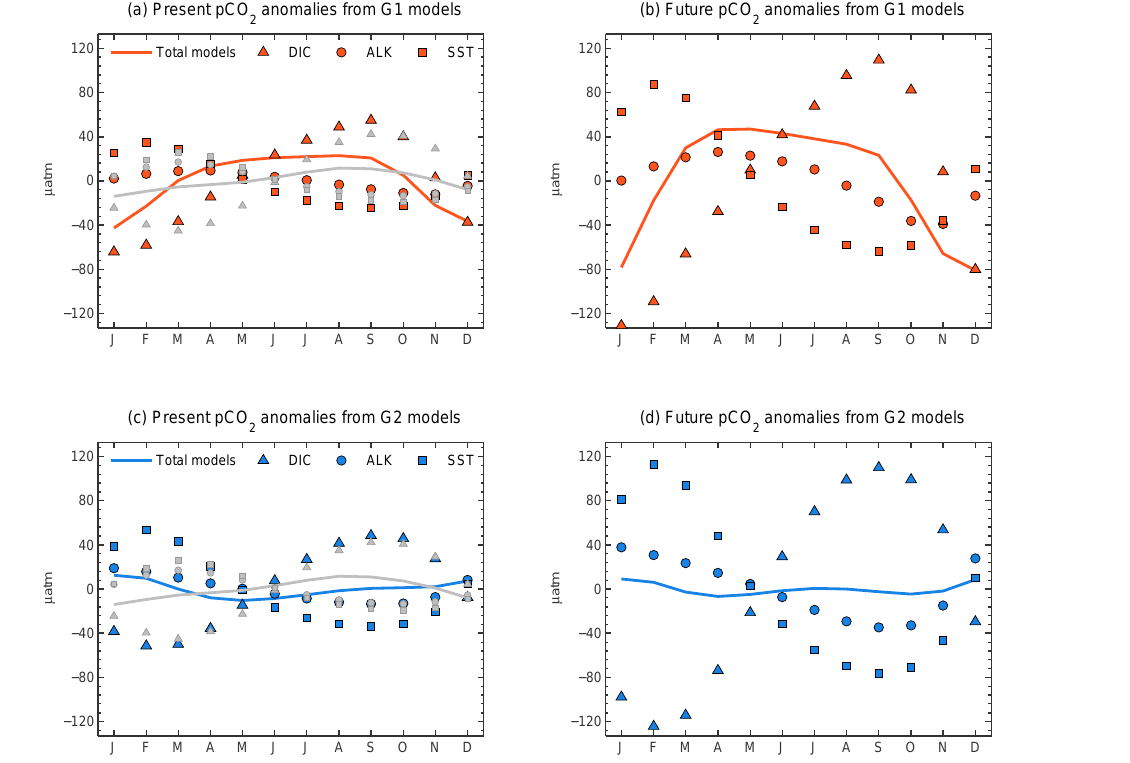
Figure 9. Anomalies of decomposed p CO 2 components in the Southern Ocean for the 2001–2010 (left panels) and future 2090–2099 (right panels) periods: (a, b) overestimating models; (c, d) underestimating models. Values shown are from multi-model mean. The gray lines and markers are estimates derived from observations according to Landschützer et al.